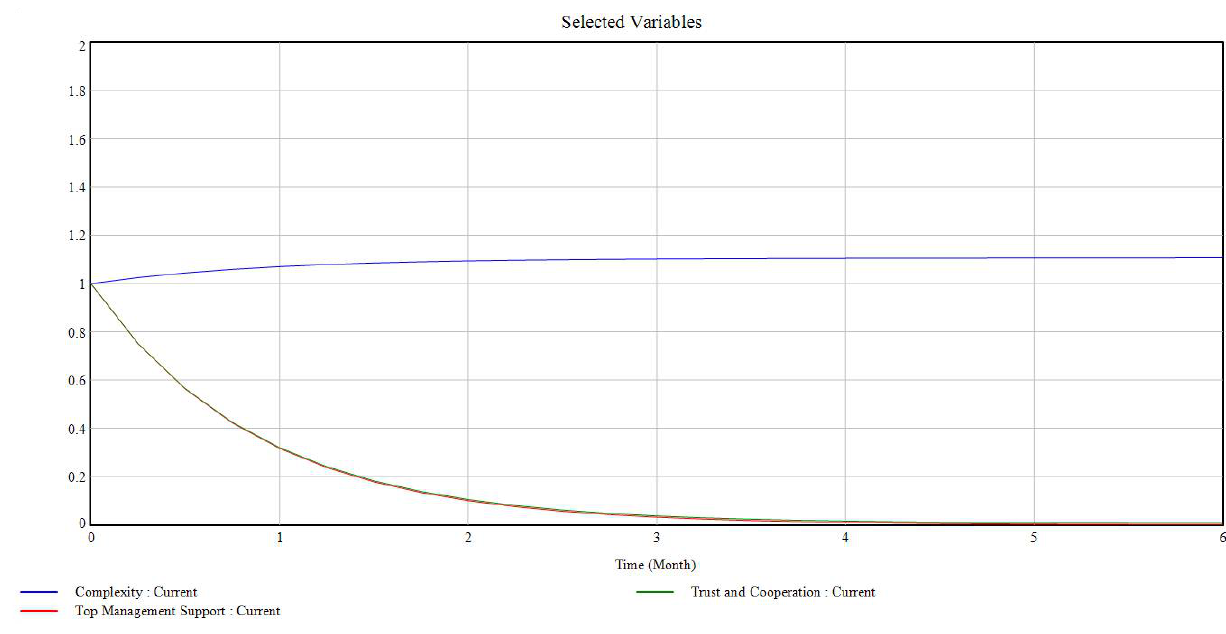
Figure 13. Simulation result of all variables.